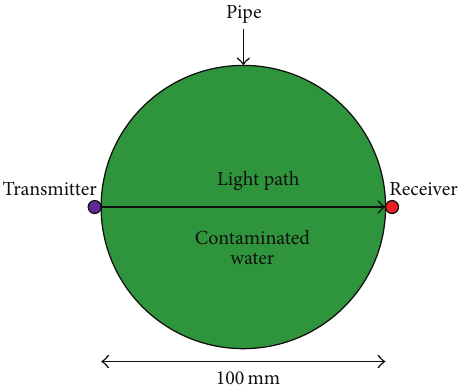
Figure 1: The light path in water when there is no gas bubble.